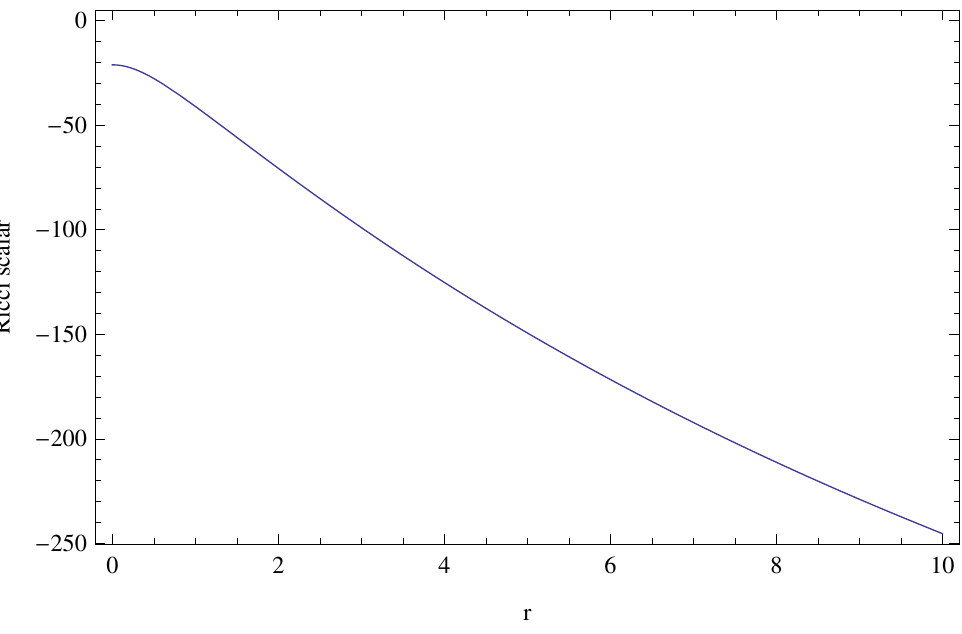
Figure 6. The Ricci scalar is plotted against the radial parameter r , for quintessence matter ( ω = − 1 for the values of constants λ = − 0.1, C 1 = 0.01, C 2 = 0.5, C 3 = 2.